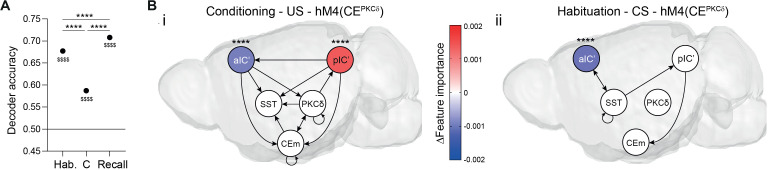
Supporting RF data and TE maps.(A) RF Da for decoding CS under control conditions in the respective stages (one-way ANOVA, F2,5997=271.60, p<0.0001). Holm-Sidak post hoc for all analyses, ****/$$$$ p<0.0001, * Indicates a significant difference as determined by two-sample t-tests, $ indicates a significant difference as determined by one-sample t-tests to random (0.5). Full statistical report in Appendix 1—table 1. (B) TE networks for (i) US in conditioning and (ii) CS in habituation under the hM4(CEPKCδ) condition. Node color corresponds to feature importance from RF decoding shown in Figure 2—figure supplement 2Aiv and v, respectively.